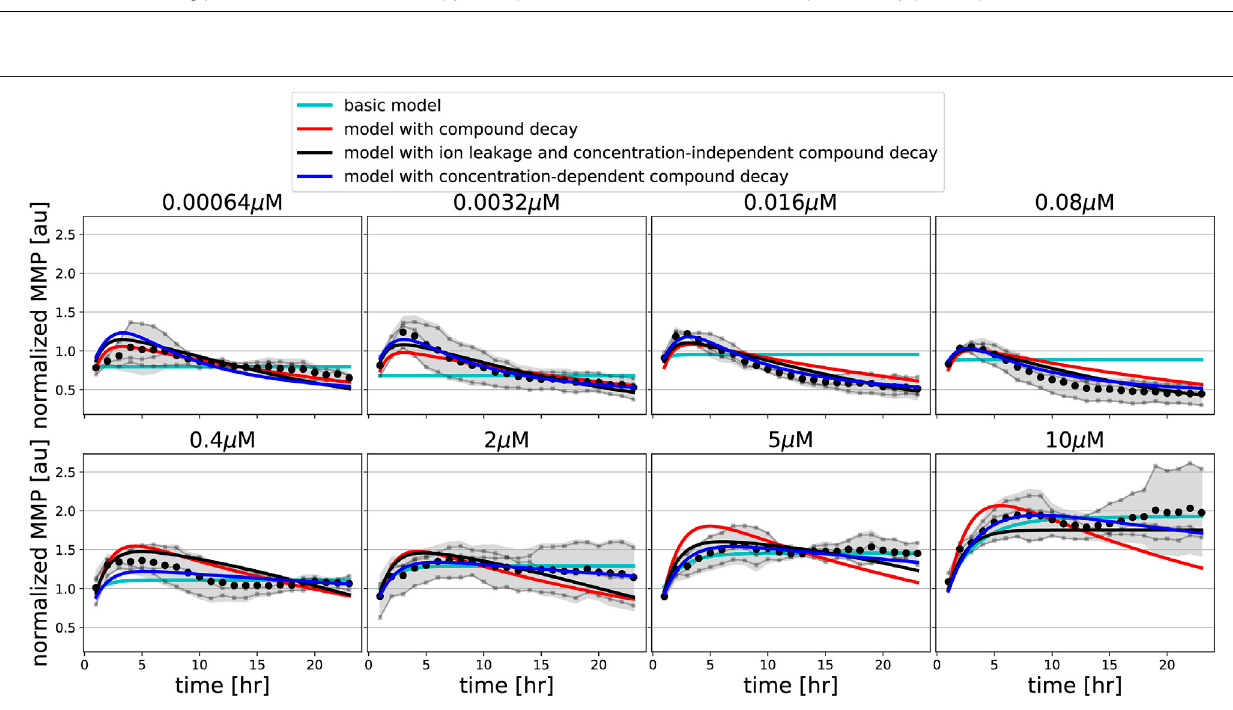
FIGURE5| Modelextensionwithcompounddegradationisrequiredforgood fi ttoFCCPdata.MMPdatainresponsetovariousconcentrationsofFCCP(grayline and dots indicate individual replicates; black dots and shading indicates the mean of replicates and 95% con fi dence intervals of means) are shown along with model simulations for best- fi tting parameters of the basic model (cyan lines) and of the model extended with compound decay (red lines).